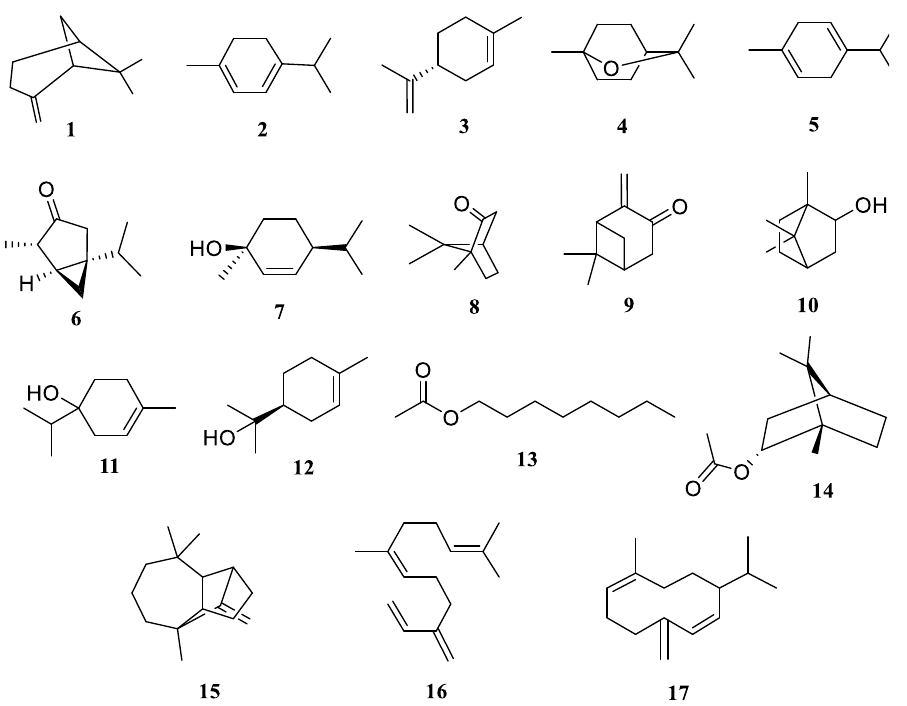
Figure 2. Chemical structure of identified compounds in C. anthemoides essential oil. ( 1 , β -Pinene; 2 , α -Terpinene; 3 , D-Limonene; 4 , Eucalyptol; 5 , γ -Terpinene; 6 , trans -Thujone; 7 , cis - para -Menth-2-ene- 1-ol; 8 , Camphor; 9 , Pinocarvone; 10 , Borneol; 11 , Terpinen-4-ol; 12 , α -Terpineol; 13 , Octanol acetate; 14 , Bornyl acetate; 15 , Longifolene; 16 , cis - β -Farnesene; 17 , Germacrene D).